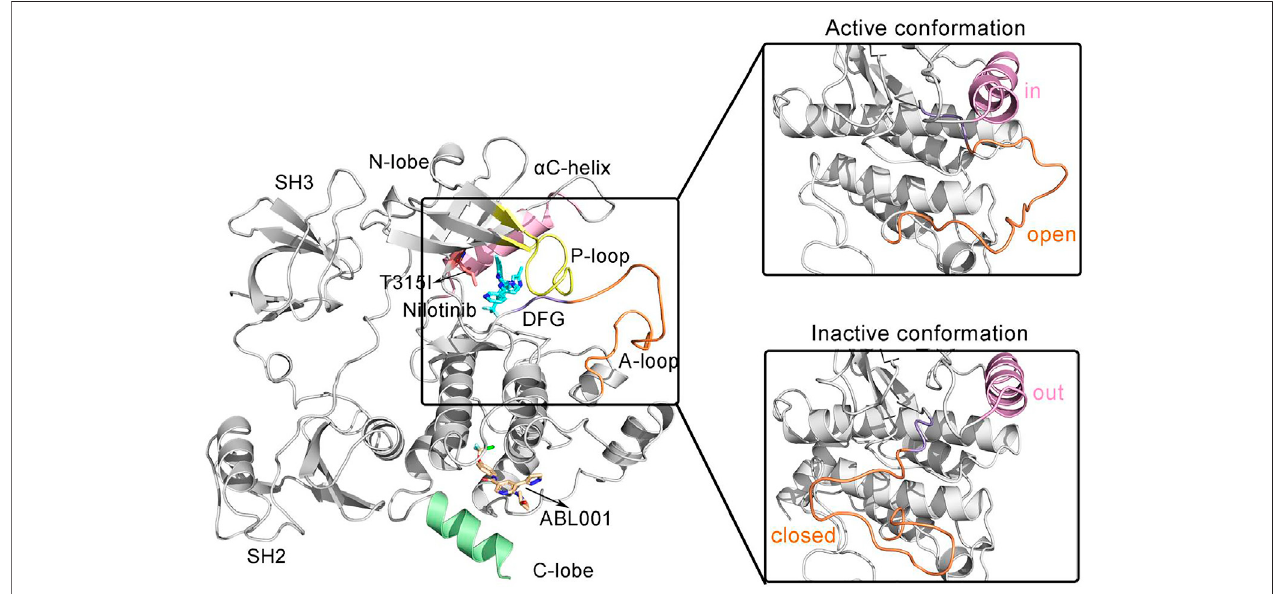
FIGURE 1 | The overall structure of the allosteric drug ABL001 (off-white) bound to the myristoyl pocket and the second generation TKI NIL (cyan) bound to the ATP-pocket in a ternary complex with BCR-ABL1 fusion protein (PDB ID: 5mo4). The backbone of BCR-ABL1 structure is represented in gray. Key structural elements are highlighted in orange (A-loop), yellow (P-loop), pink ( α C-helix), and purple (DFG motif),